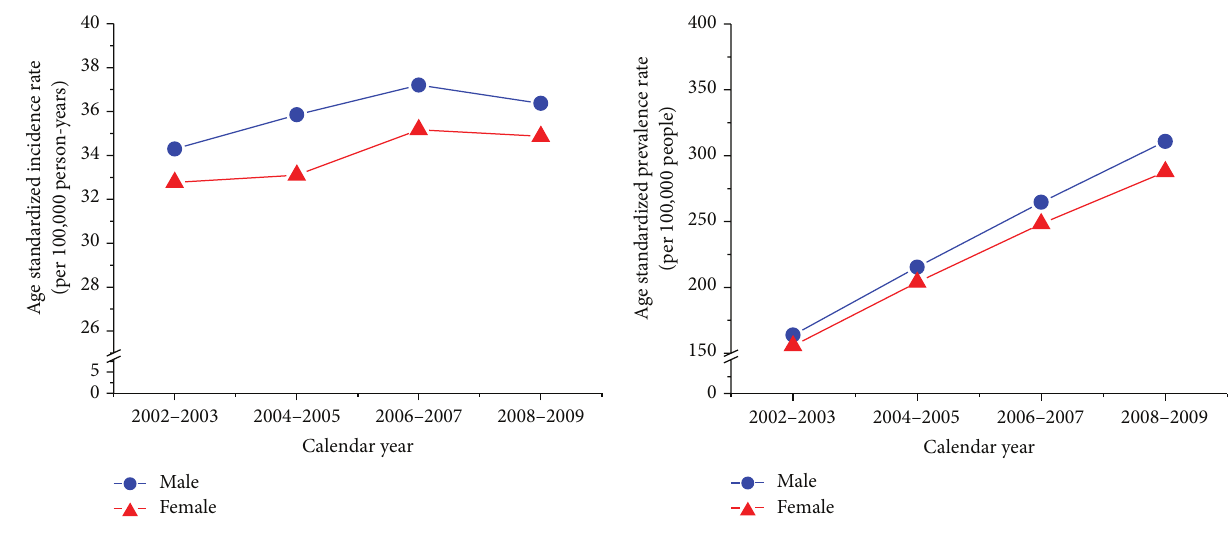
Figure 1: Age-standardized prevalence and incidence rates of Parkinson’s disease in Taiwan, 2002–2009.